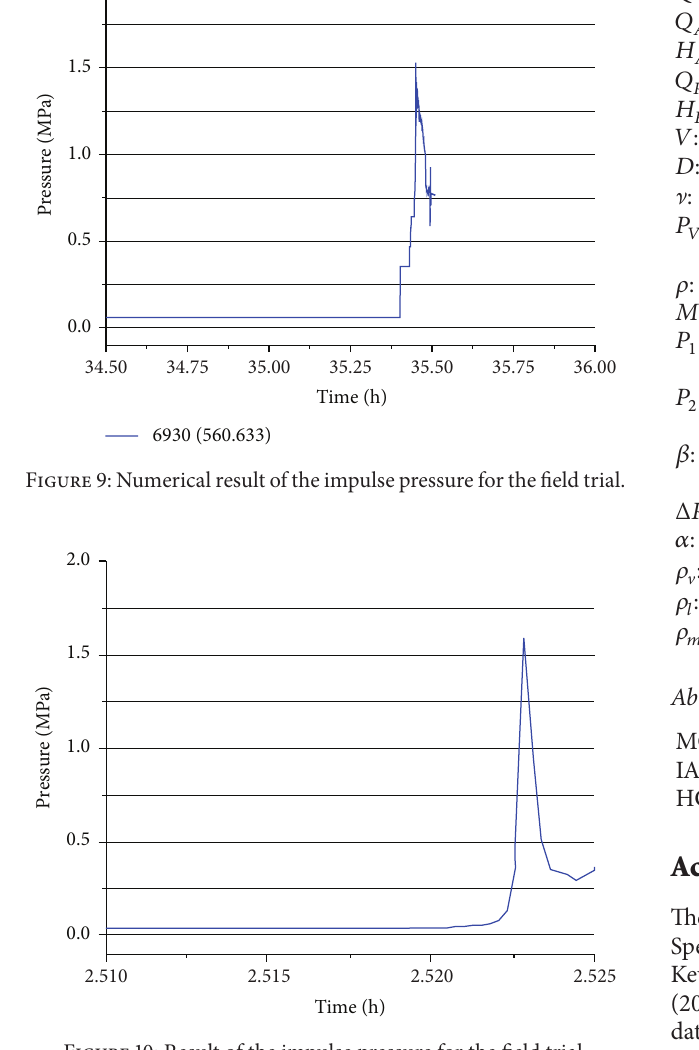
Figure 10: Result of the impulse pressure for the field